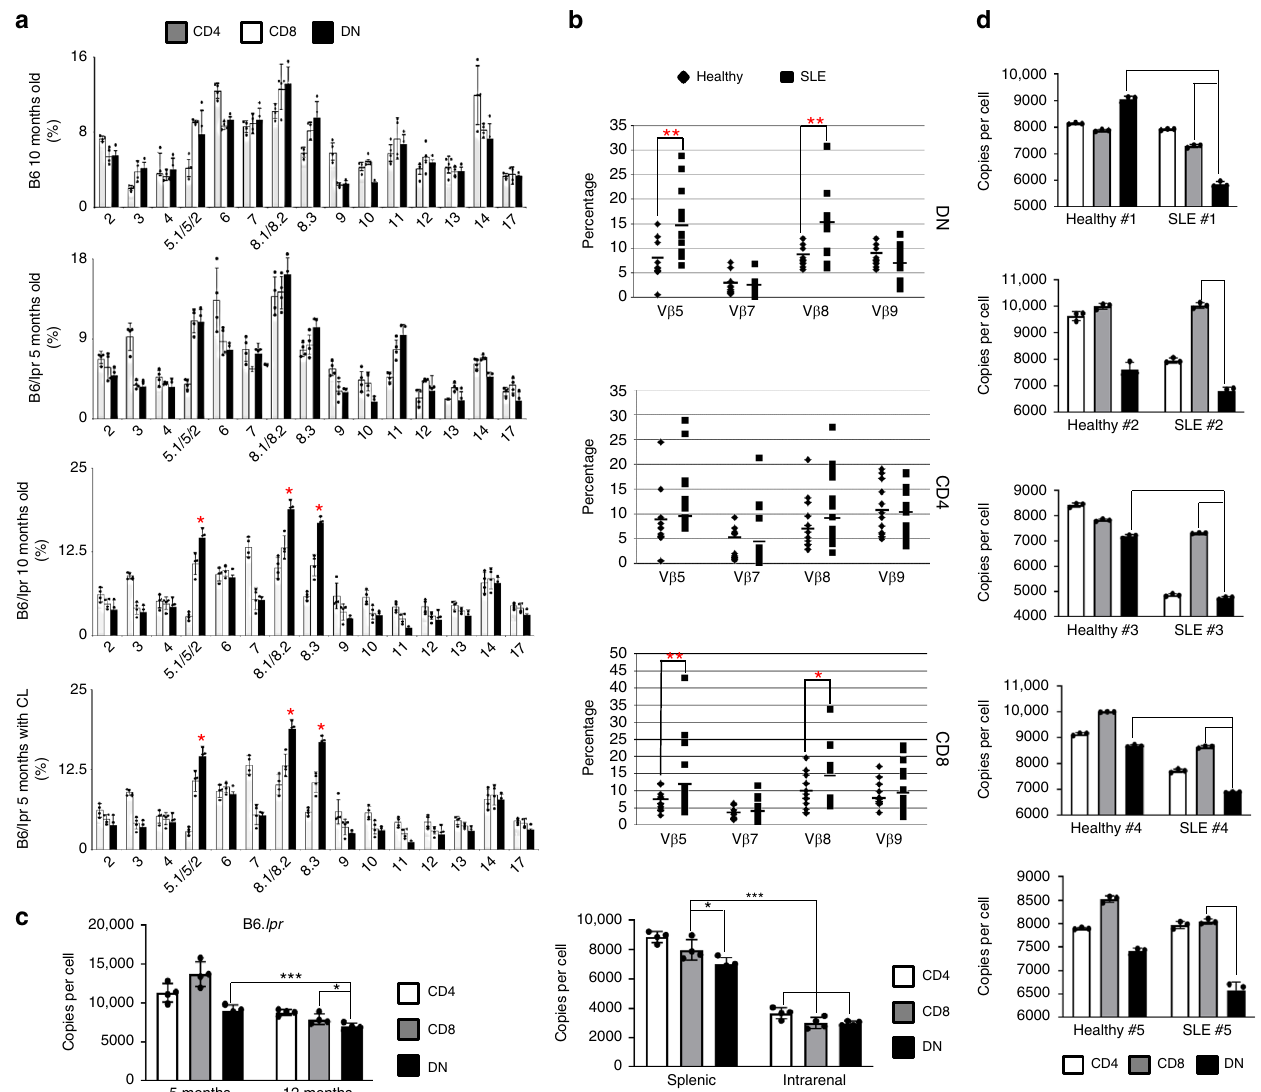
Fig. 7 Skewed TCR V β repertoires and diluted TREC of DN T cells. a Bar graphs show quantitation of TCR V β usage by CD4, CD8, and DN T cells of spleens from indicated mice. CD4 T cells: CD3 + TCR β + NK1.1 − CD4 + , CD8 T cells: CD3 + TCR β + NK1.1 − CD8 + , DN T cells: CD3 + TCR β + NK1.1 − CD4 − CD8 − , bottom: female B6. lpr mice were treated with clodronate liposomes (CLs, 100 ug/mouse) every other week for 2 months total starting at 3 months of age. n = 4 mice per group. b Scatter plots show the quantitation of TCR V β usage by DN, CD4, and CD8 T cells in PBMC from either healthy controls or SLE patients. CD4 T cells: CD3 + TCR β + CD56 − CD4 + , CD8 T cells: CD3 + TCR β + CD56 − CD8 + , DN T cells: CD3 + TCR β + CD56 − CD4 − CD8 − . n = 12 each group. c Left: quantitative real-time PCR analysis of TCR excision circles in CD4, CD8, and DN T cells in spleens from B6. lpr with indicated ages. Right: